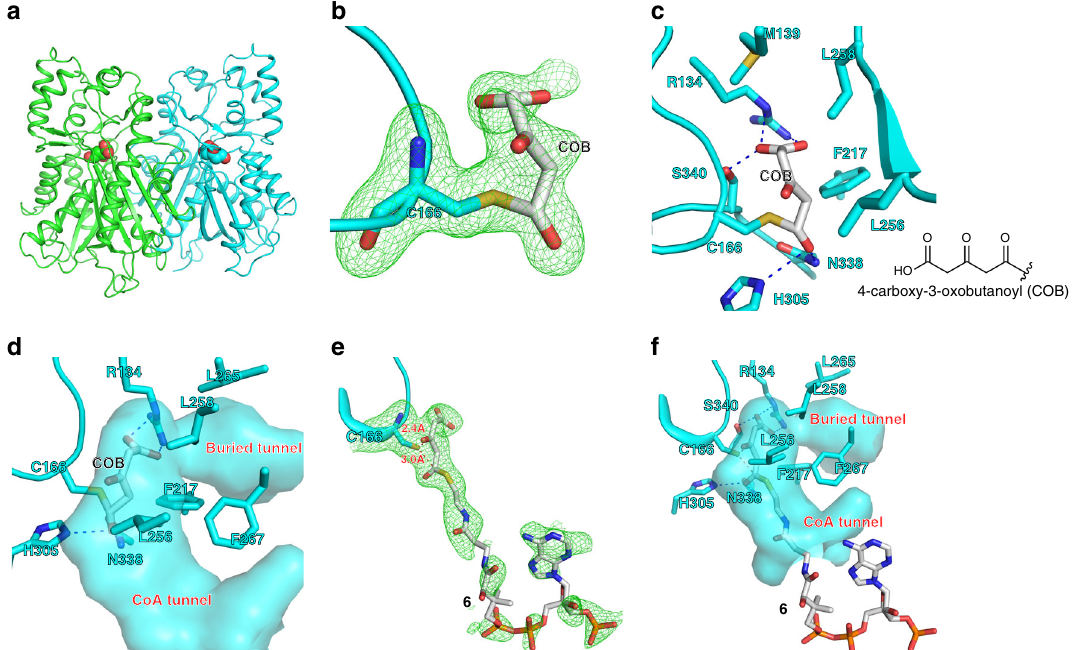
Fig. 3 Crystal structures of Aa PYKS-COB (PDB ID: 6J1M) and Aa PYKS- 6 (PDB ID: 6J1N). a Aa PYKS-COB is a dimer (cyan and green ribbon). The 4- carboxy-3-oxobutanoyl (COB) thioester is shown as spheres. b The F O – F C electron density polder map contoured at 5 σ of the catalytic residue C166 and the covalently bound COB. c The detailed interactions of COB with Aa PYKS residues. d The surface presentation of Aa PYKS shows the inner tunnels. e The F O – F C electron density polder map contoured at 3 σ of the catalytic residue C166 and 6 . f The surface presentation of Aa PYKS- 6 shows the inner tunnels. N, O, S, and P atoms are colored as blue, red, yellow, and orange, respectively. C atoms of protein residues and small molecules are colored as cyan and white,